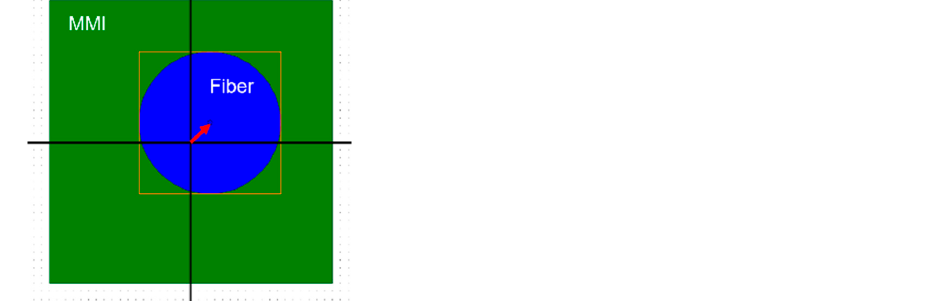
Figure 10. Schematic of the off-centred input fibre with the direction shown by the red arrow.